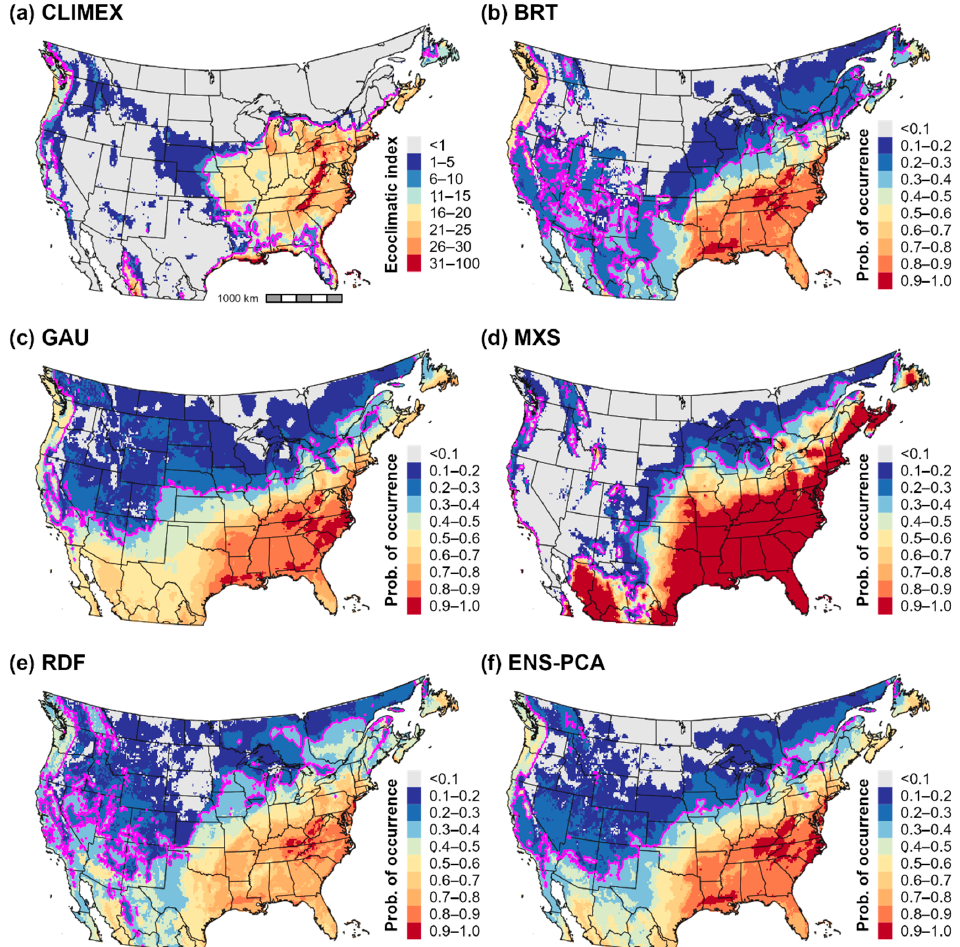
Figure 5. Maps of climatic suitability for Calonectria pseudonaviculata in the contiguous United States and bordering areas in North America. Climatic suitability is estimated as the ecoclimatic index in the ( a ) CLIMEX model and as the probability of occurrence in ( b – f ) correlative models produced using boosted regression trees (BRT), Gaussian process (GAU), Maxent “simple” (MXS), random forest (RDF), and a principal component analysis of predictions (ensemble) produced by the four algorithms (ENS-PCA). Pink lines delineate the thresholds used to binarize models into presence–absence predictions: ecoclimatic index ≥ 10 for the CLIMEX model and probability of occurrence ≥ 0.3 for correlative models. Areas with relatively high climatic dissimilarity to the correlative model calibration area (MOP values <0.9) are depicted in Figures 6, 8 and 9.